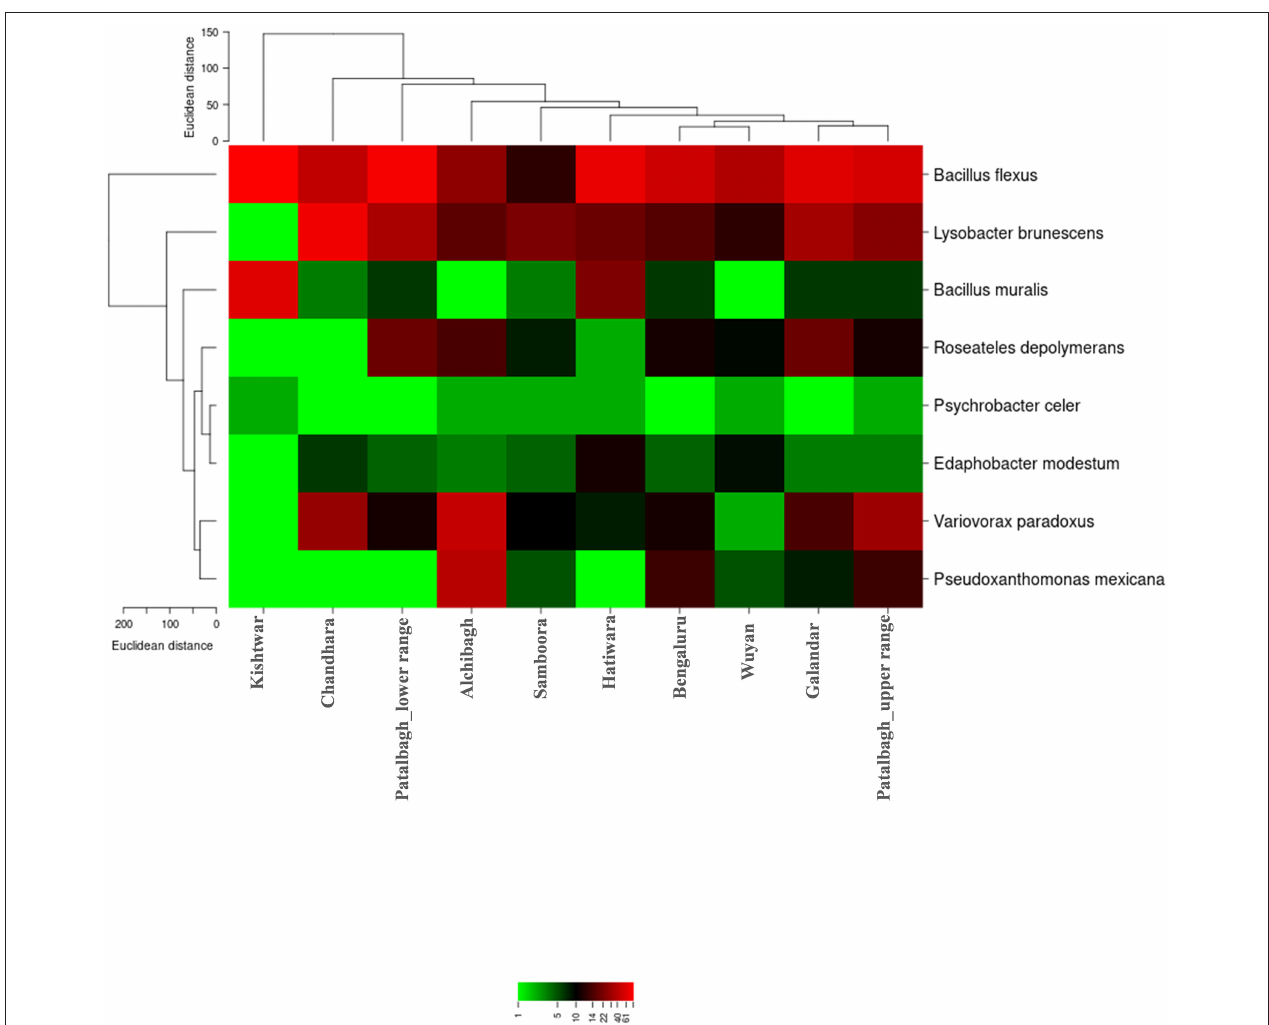
FIGURE 10 | Heat map representing the relative abundance of core bacterial species (8) in the Saffron rhizosphere from 10 different samples. Saffron rhizo-bacteriome in Kishtwar was different than rest of the samples as represented by phylogenetic tree comparing all the